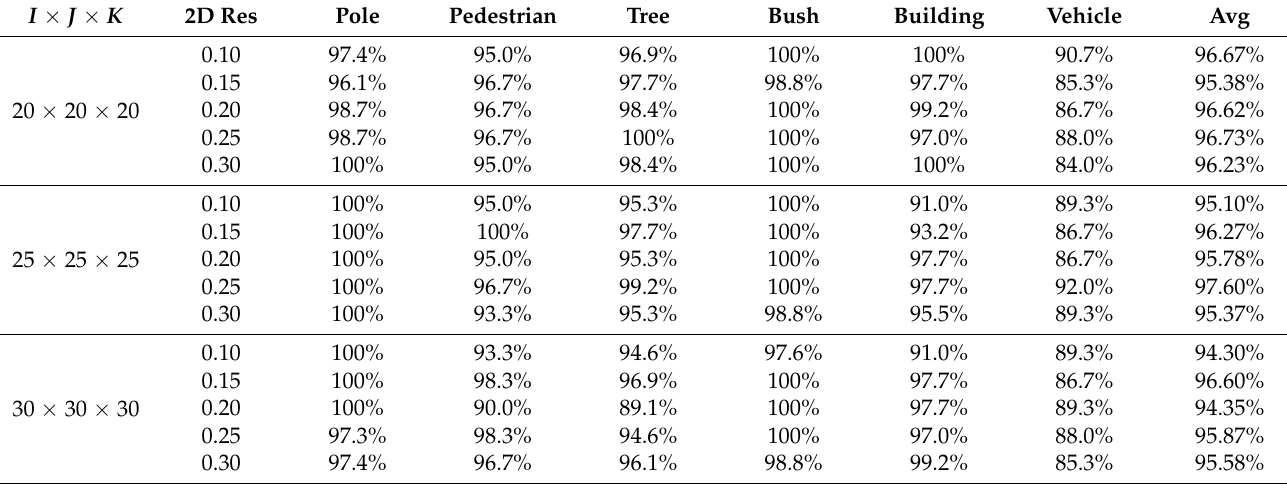
Table 4. Classification performance of the